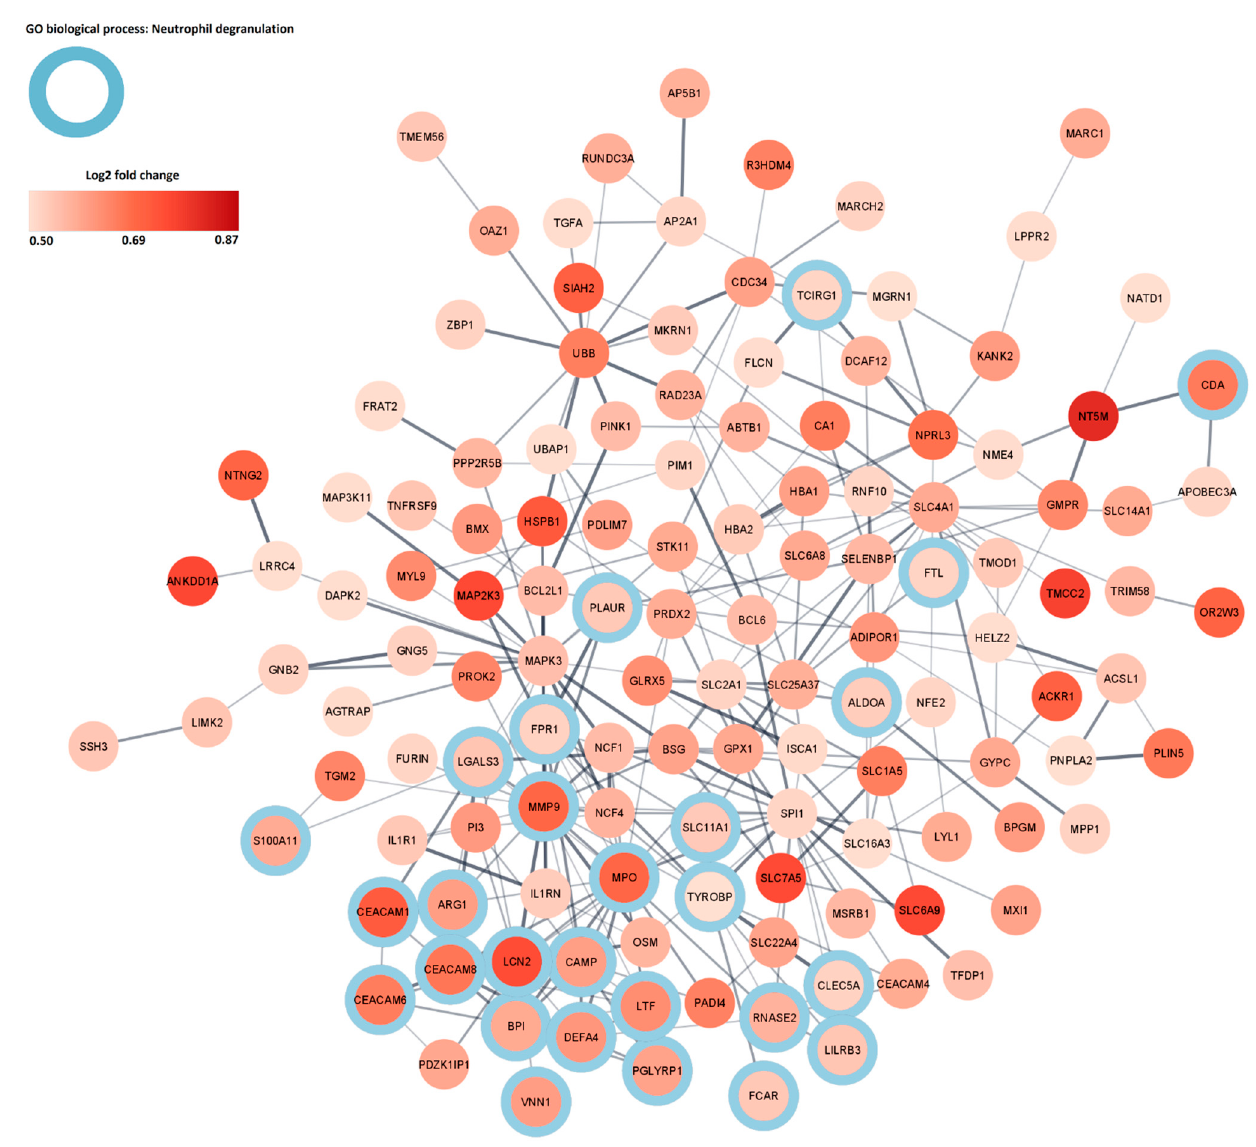
Figure 2. Protein–protein interaction (PPI) network of upregulated DEGs. The network contained 130 nodes and 287 edges. The color gradient of the nodes indicates the log2 fold change of the DEGs, the edge thickness represents the PPI strength, blue circles indicate annotation to GO biological processes of neutrophil degranulation.